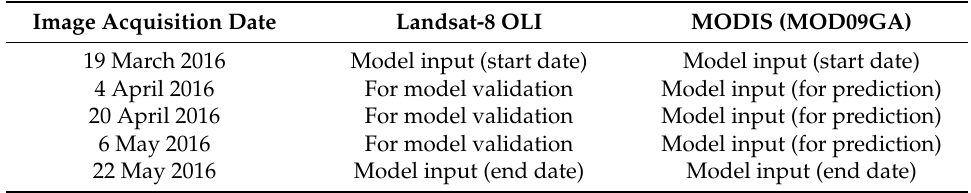
Figure 1. Red-NIR-SWIR1 (R-G-B) false color composites of the two pairs of Landsat-8 OLI surface reflectance ( lower row ) and MODIS surface reflectance bands 1-2-6 false color composites ( upper row ) used for a prediction of Landsat-like image time series between 19 March 2016 and 22 May 2016. The yellow and reddish colors on the images of the left show snow and ice coverage. Table 1. Images, acquisition dates and their